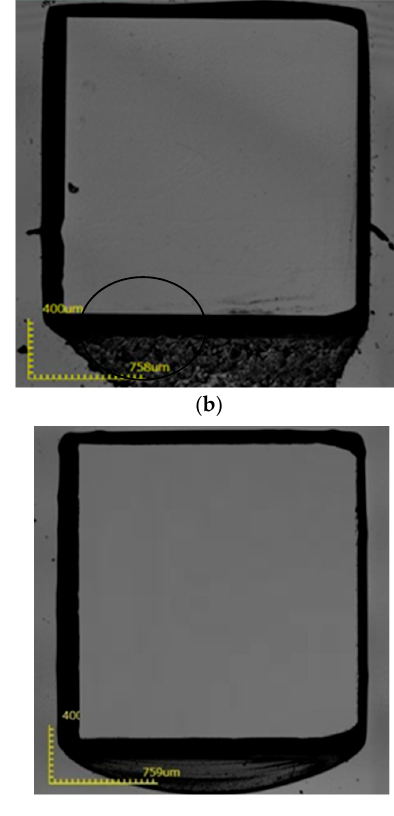
Table 5. Process resu lts at 300 °C.